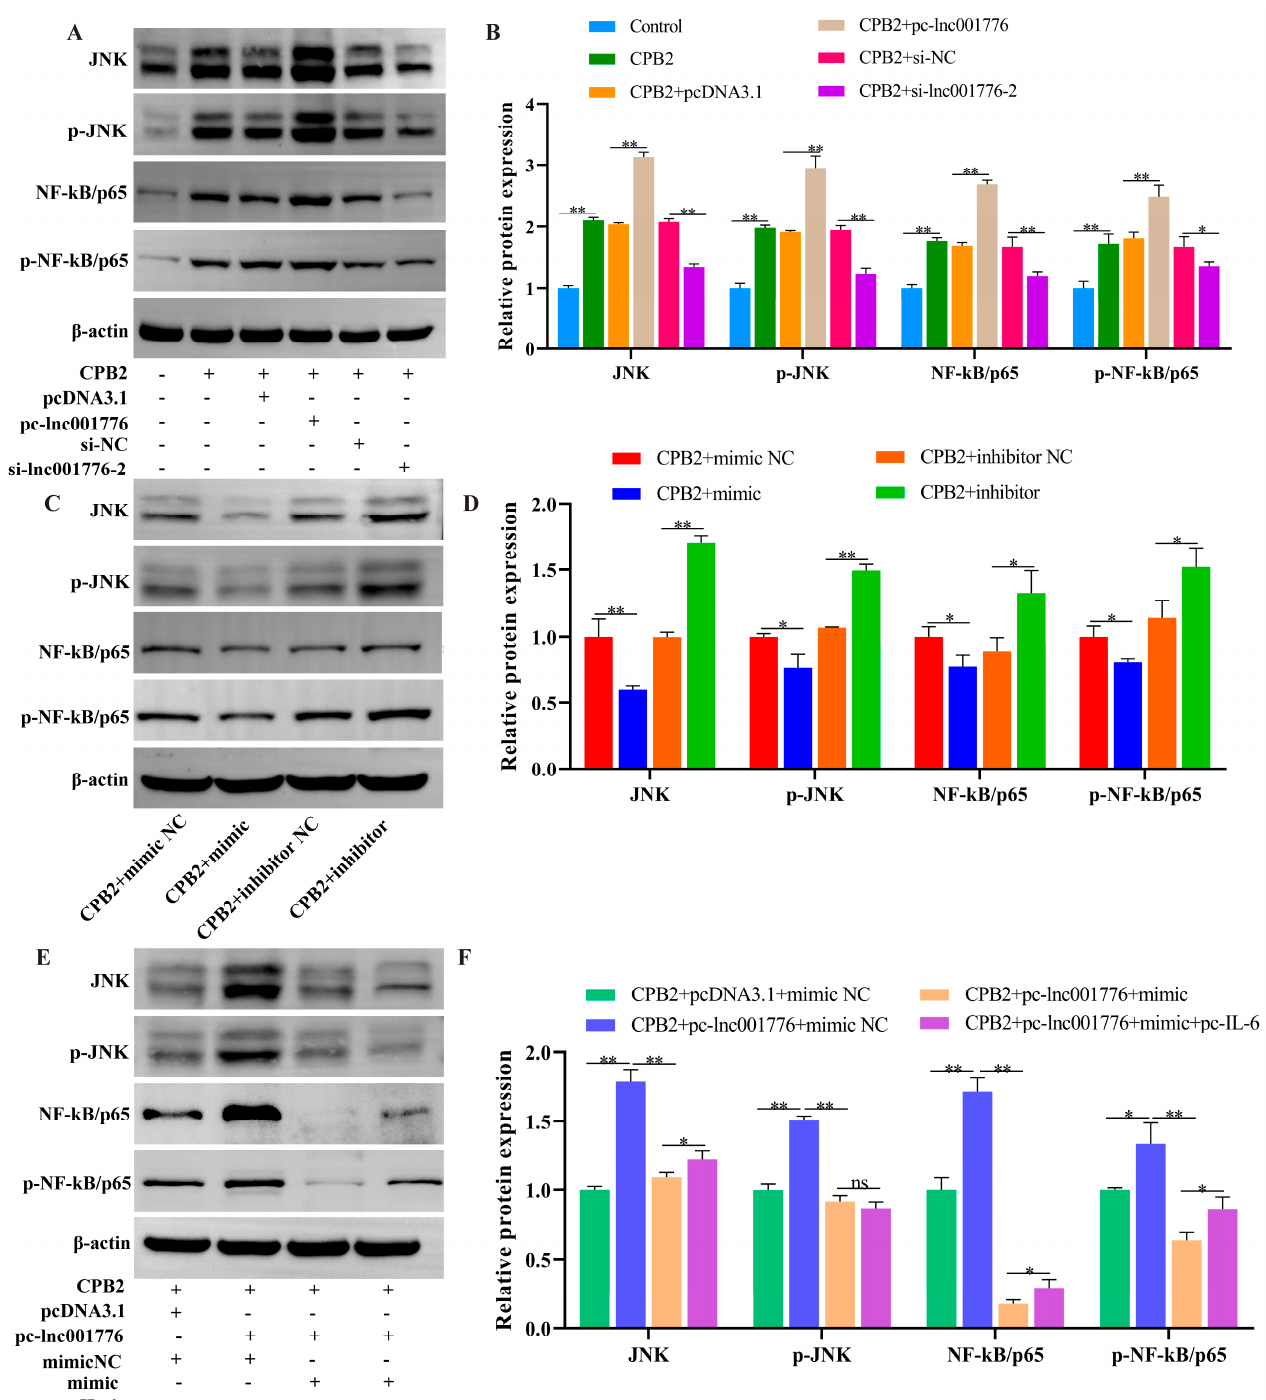
Figure 11. Overexpression of lnc001776 activated JNK/NF-kB pathway via ssc-let-7i-5p/ IL-6 axis. ( A , B ) JNK, p-JNK, NF-kB/p65 and p-NF-kB/p65 protein levels after overexpression and knockdown of lnc001776. ( C , D ) JNK, p-JNK, NF-kB/p65 and p-NF-kB/p65 protein levels after overexpression